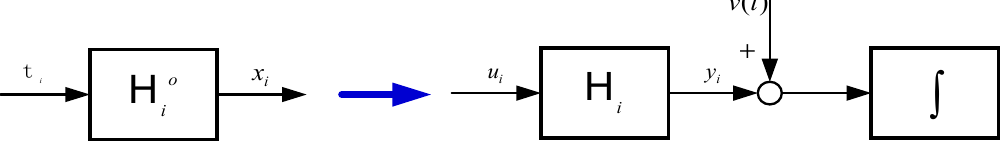
Figure 4. Description of Step 1. Step 1 transforms agent dynamics from (12) to (13) by designing an internal feedback t i . The resulting passive block is denoted by H io